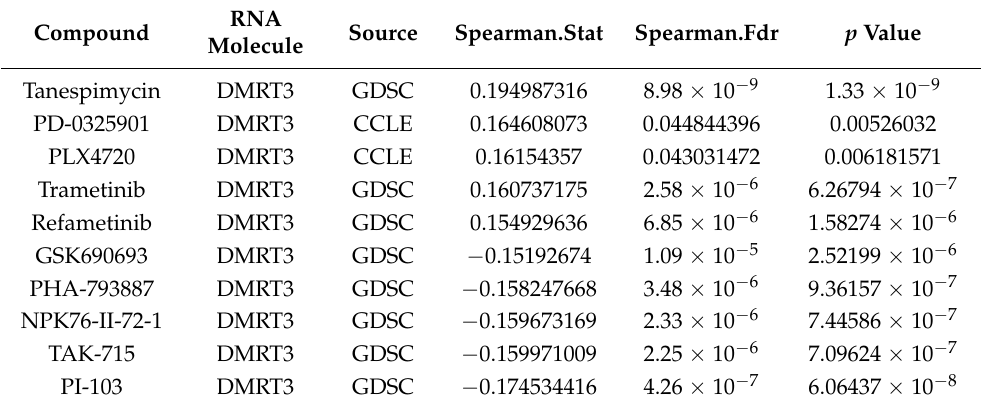
Table 1. Drug sensitivity analysis of